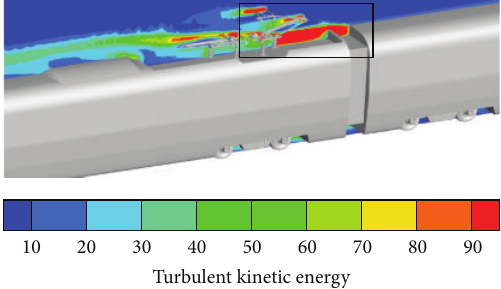
Figure 24: TKE distribution of the pantograph fairing region with the train running in the reverse